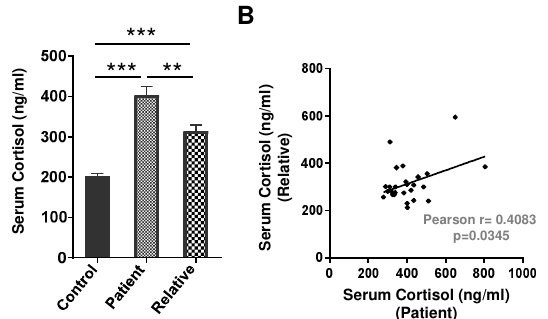
Figure 3. ( A ) Serum cortisol level in drug-naive depression patients ( n = 29), their first-degree rela- tives ( n = 27), and healthy volunteers ( n = 24). Data expressed as mean ± SEM. F (2, 77) = 36.23; ** p < 0.01 and *** p < 0.001. ( B ) Correlation in serum cortisol levels between patients and their first- degree relatives.